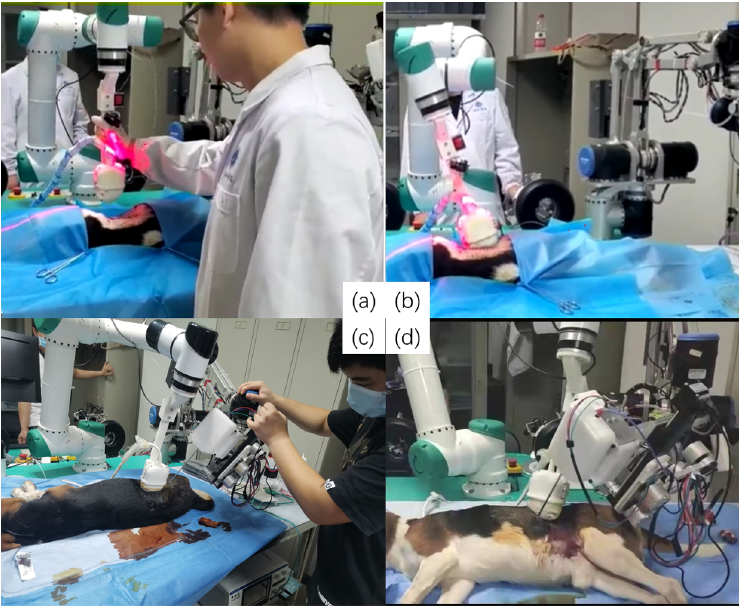
Figure 17. The prototype of dual-armed robotic puncture system and system composition.